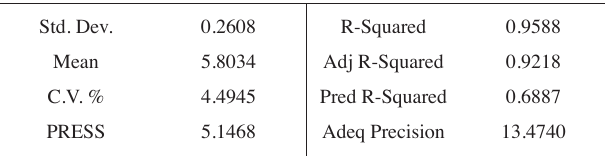
Tab. 4: Significance test table of regression